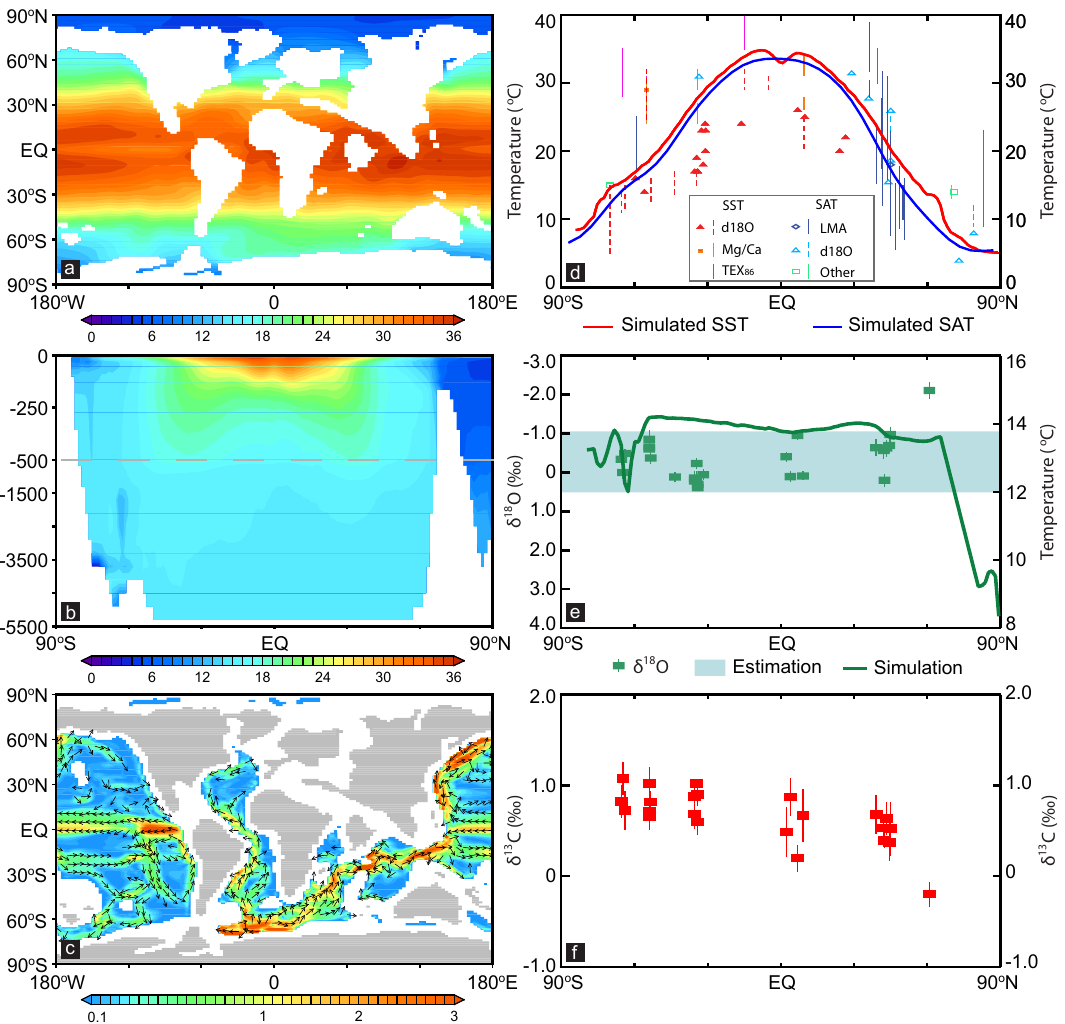
Figure 1. Warm climate and SODW-dominated ocean circulation simulated in the Early Eocene (EECO) experiment. (a) Sea surface temperature (SST, o C). (b) zonal mean ocean temperature ( o C). (c) Deep ocean circulation (cm/s) at 2500m. Arrows show flow directions, and colour scales show current speed. (d) Comparison of latitudinal sea surface temperature between the model simulation and proxy records. LMA means leaf-margin analysis. (e) Comparison of deep water temperature among the simulation (bold green line), paleotemperature estimation (green shaded bar) (Lear et al., 2000) and benthic foraminiferal δ 18 O (small green markers). (f) Latitudinal gradients of benthic foraminiferal δ 13 C in the Early Eocene. All geological data used here are listed in the supplementary materials.